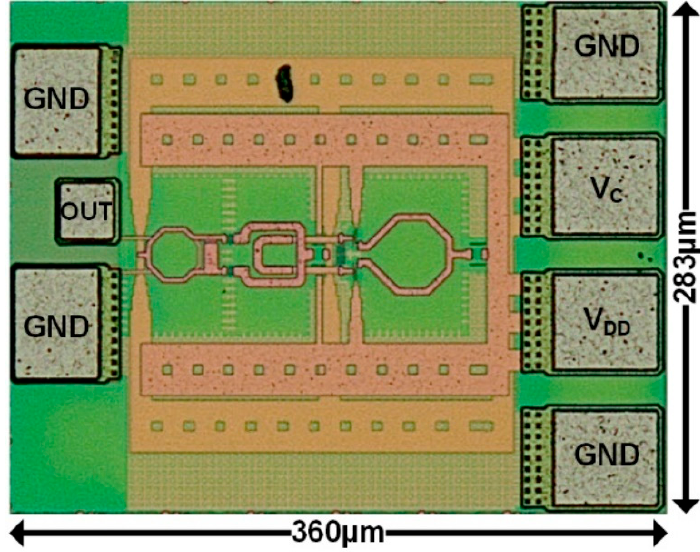
Figure 6. Chip micrograph of the proposed oscillator.